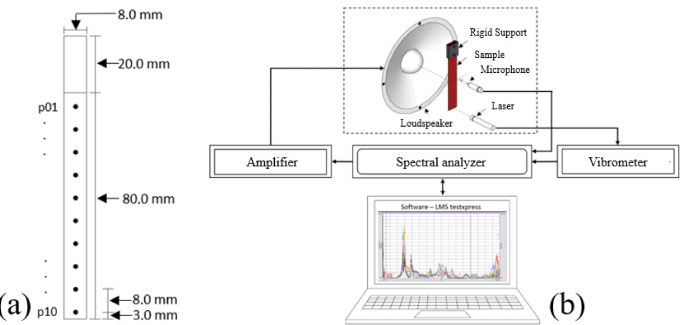
Figure 1. Detail of ( a ) samples and ( b ) instrumentation for cantilever beam modal analysis.